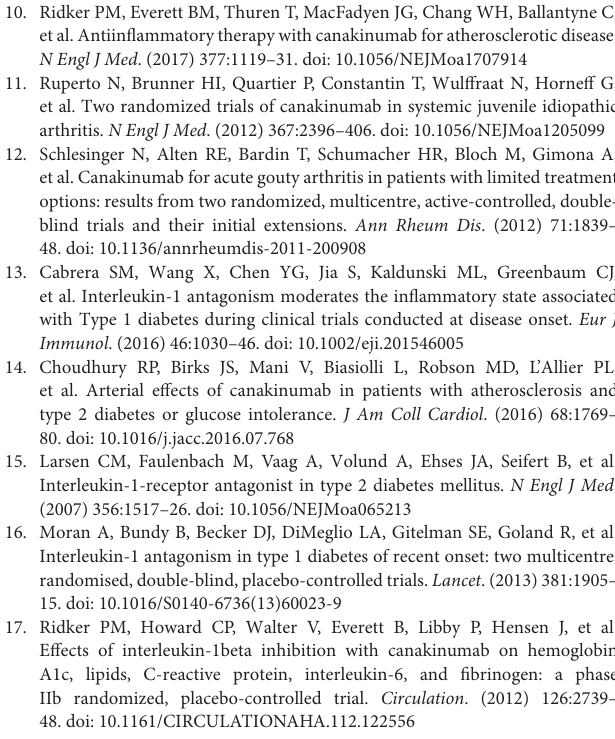
Supplementary Figure 1 | Kidney pathology evaluation of anti-IL-1 β IgG on type 2 diabetic db/db mice. (A) Area of glomerular tuft (encircled by yellow lines), area of Bowman’s capsule (encircled by green line), and the ratio of tuft over capsule were measured in PAS staining at an original magnification of 400X. (B) Kidney sections of all groups were stained for alpha-smooth muscle actin (aSMA) to quantify kidney fibrosis. Original magnification 25x. (C) Kidney sections of all groups were stained for Sirius red to quantify the glomerular collagen deposition. (D,E) Glomerulosclerosis was quantified in all groups upon staining kidney sections with sirius red by using automated digital morphometry upon selecting only tuft areas. Original magnification 400x. Data represent means ± SEM. ∗ p < Supplementary Figure 2 | Kidney gene expression by RT-PCR in animal study. (A–G) Pro-inflammatory cytokine and chemokine gene expression was quantified. (H,I) Tubular injury genes of KIM-1 and Ngal were measured. (J,K) Extracellular matrix gene expression were quantified as described in